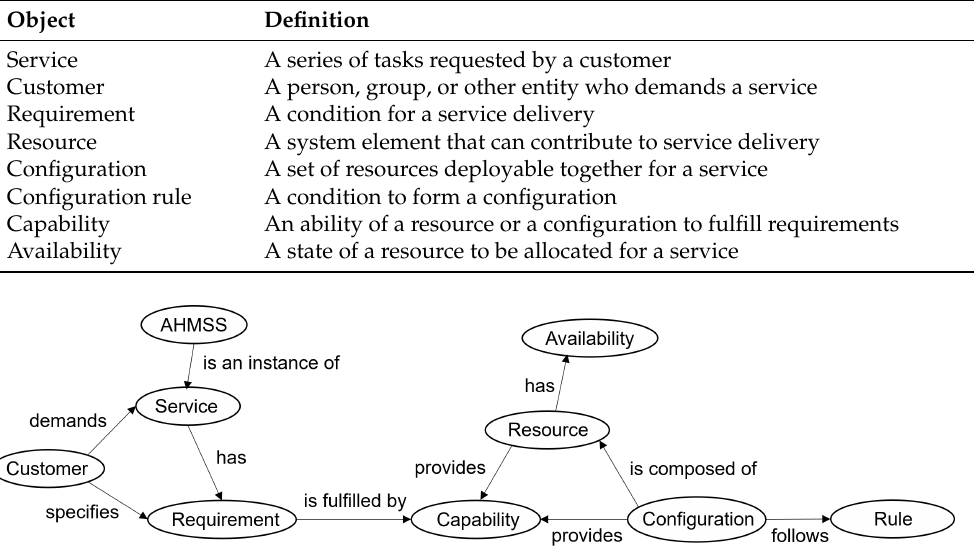
Table 1. Main objects of an AHMSS, reproduced from [6]